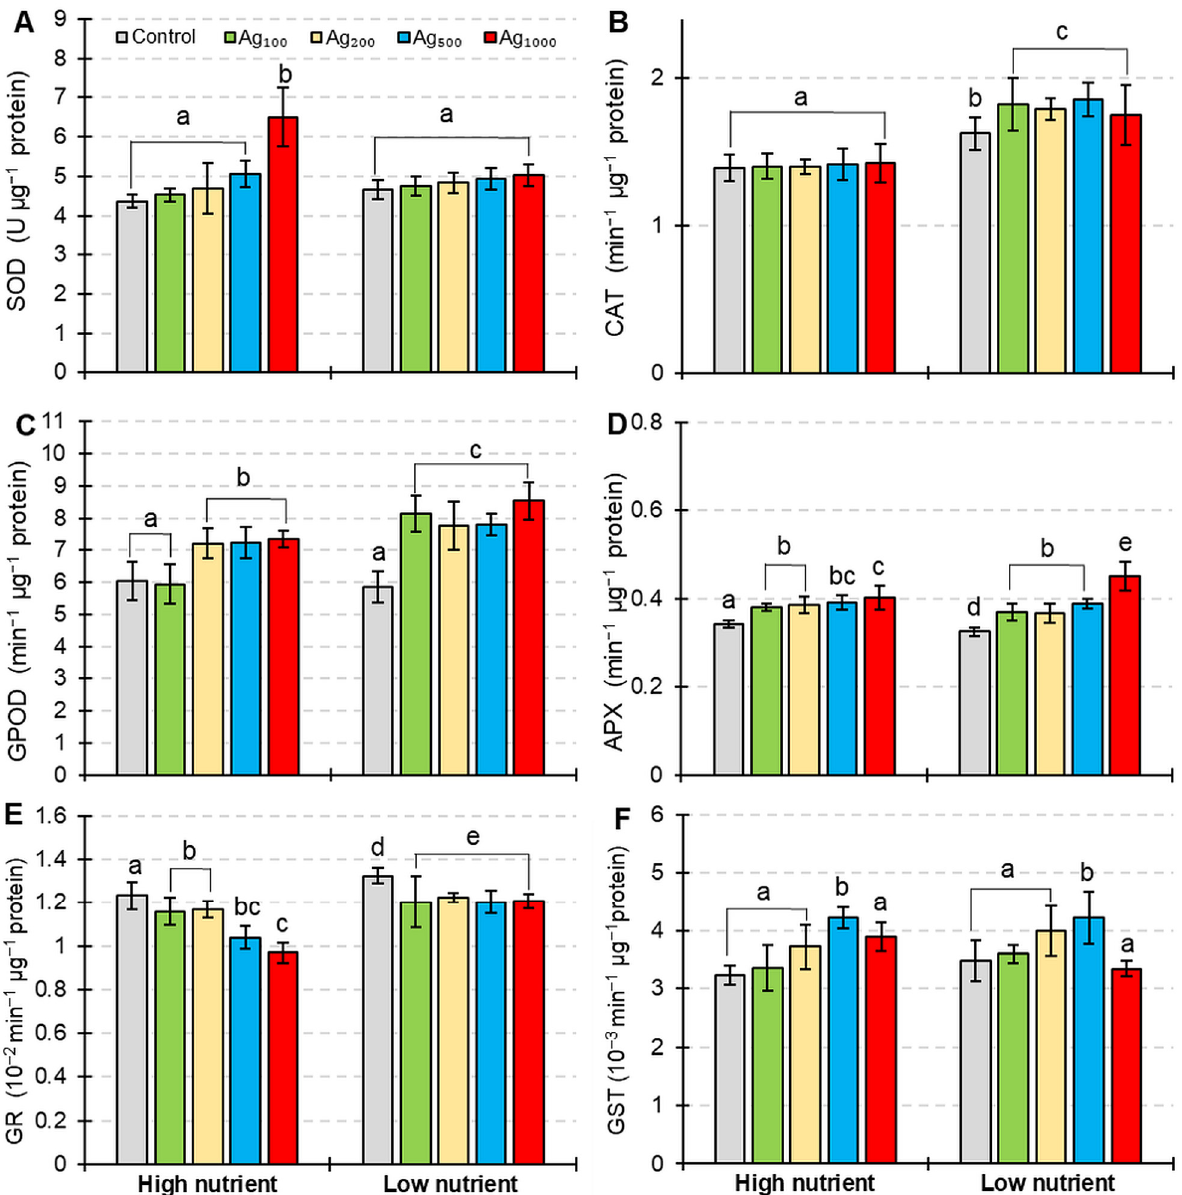
Figure 4. The speci fi c activity of ( A ) SOD, ( B ) CAT, ( C ) GPOD, ( D ) APX, ( E ) GR, and ( F ) GST in L. gibba exposed to a two-hour pulse of di ff erent colloidal silver concentrations (control = 0 µg/L; Ag ₁₀₀ = 100 µg/L; Ag ₂₀₀ = 200 µg/L; Ag ₅₀₀ = 500 µg/L; Ag ₁₀₀₀ = 1000 µg/L) combined with two levels of total nitrogen and total phosphorus nutrition (high nutrients; low nutrients). Values shown are mean ± standard deviation of ten replicates ( n = 10). Di ff erent le tt ers indicate signi fi cantly di ff erent values (HSD, p < 0.05).